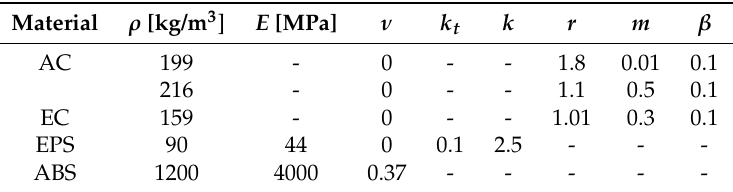
Table 1. Material properties used as input in Abaqus material models.